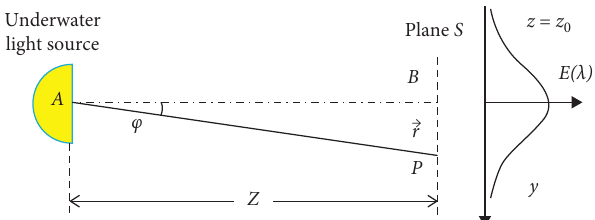
Figure 2: Underwater light field distribution. Plane S is perpen- dicular to the optical axis of the underwater light source, the distance between them being z. The distance between points P and → B is denoted as r . For any perpendicular plane located at a distance z � z 0 from the underwater light source, the irradiance E ( λ ) at any point generally decreases with its distance to the optical